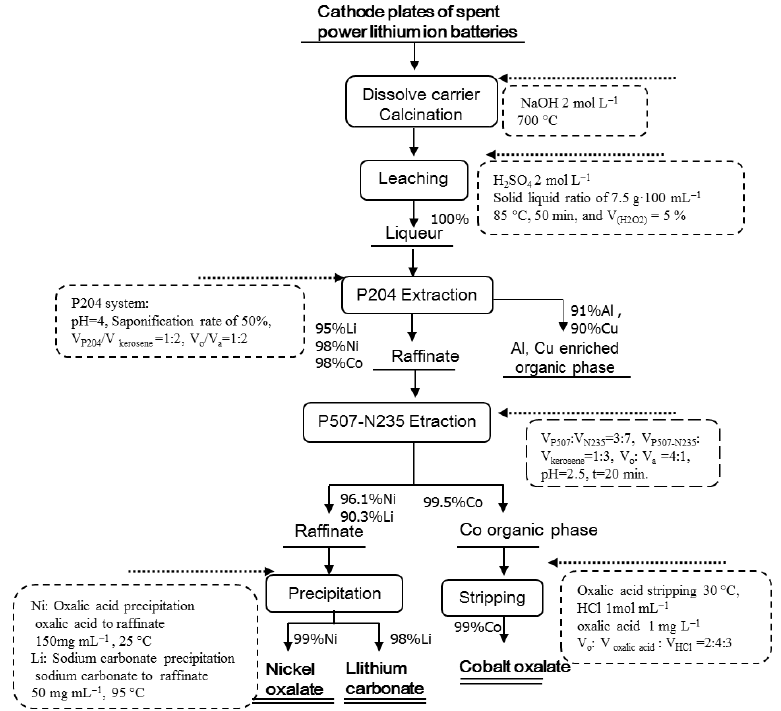
Figure 2. Flow chart of the recovery process route.